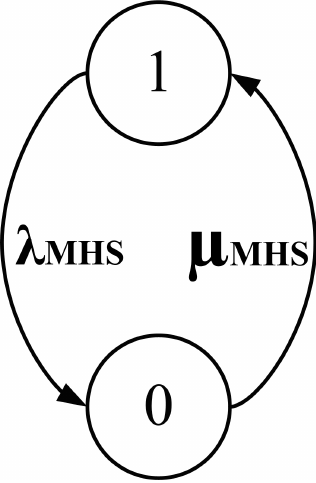
Figure 3. State transition diagram of the material handling system (MHS).